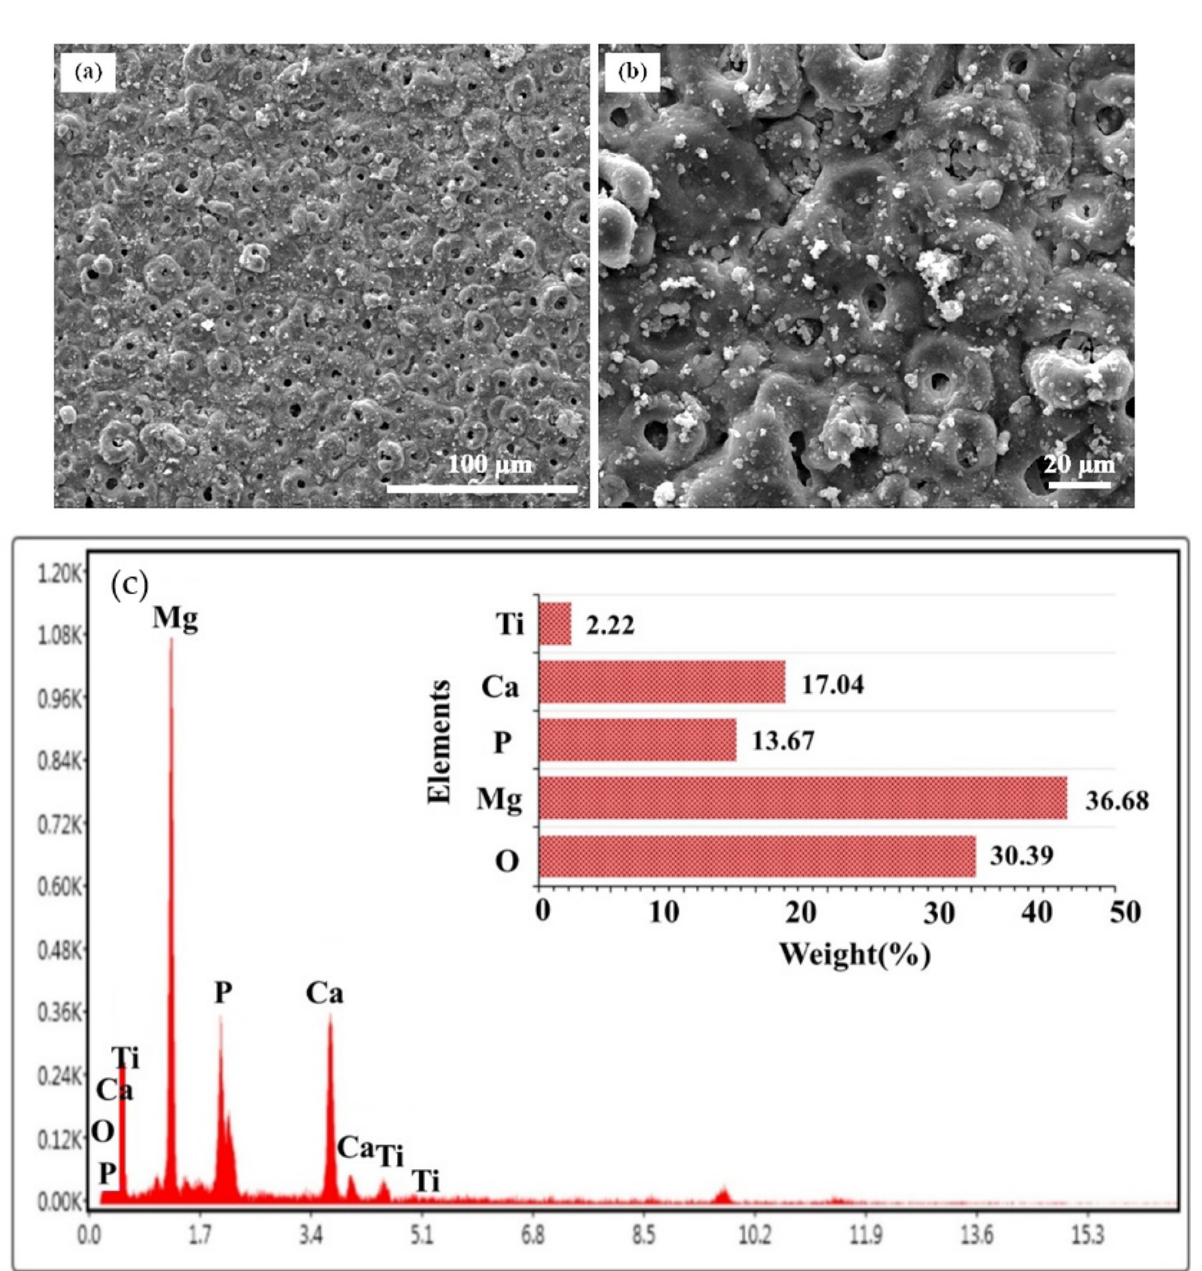
Figure 12. ( a , b ) The FE-SEM surface morphology micrographs two-magnified and ( c ) EDS point spectra of T1 sample after 72 h of immersion to SBF.